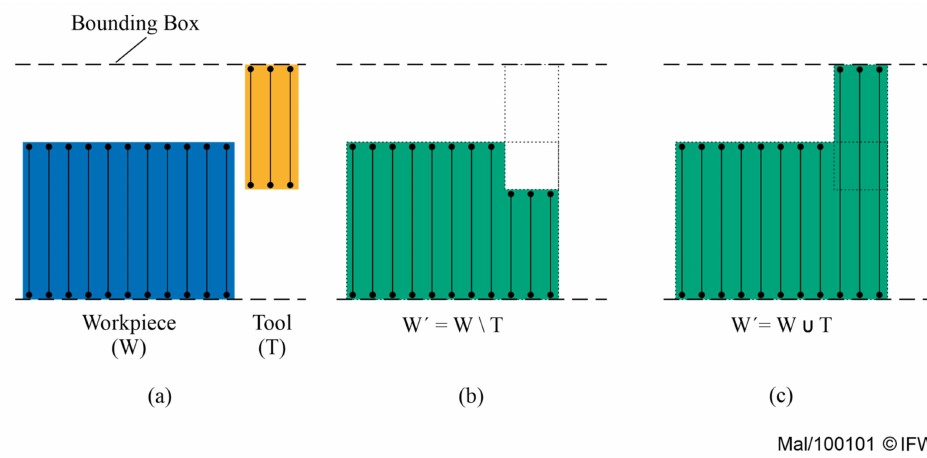
Figure 2. Algebraic operations: ( a ) initial situation; ( b ) intersection; ( c )